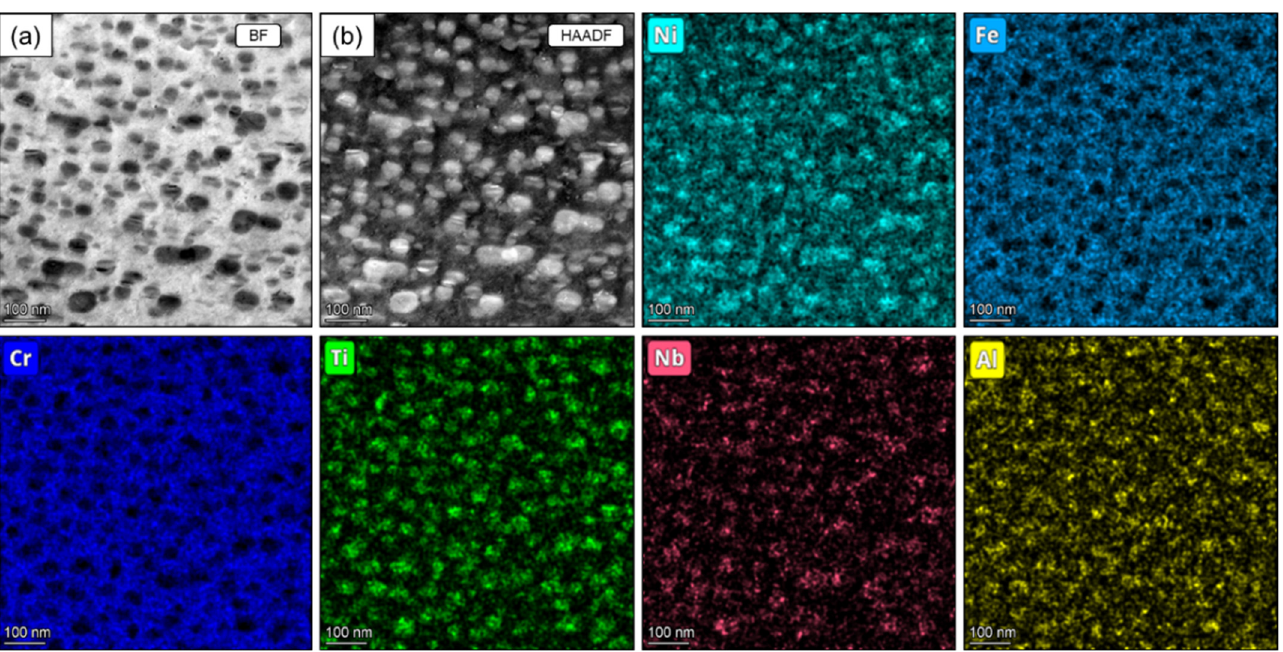
Figure 6. Bright-field, HAADF-STEM image, and the related EDS mapping results of the γ ’ phase in the 5# sample: ( a ) the bright-field image, ( b ) HAADF image of ( a ).